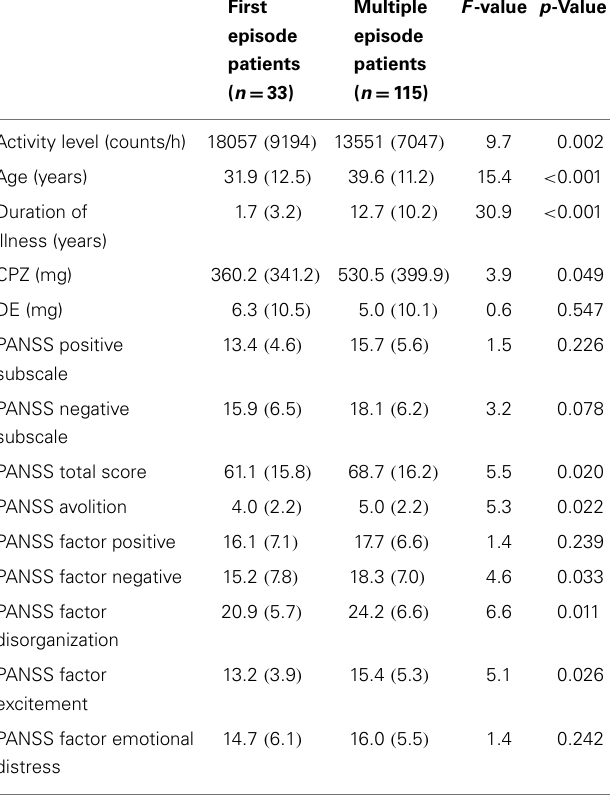
Table 1 | Clinical and demographic characteristics .